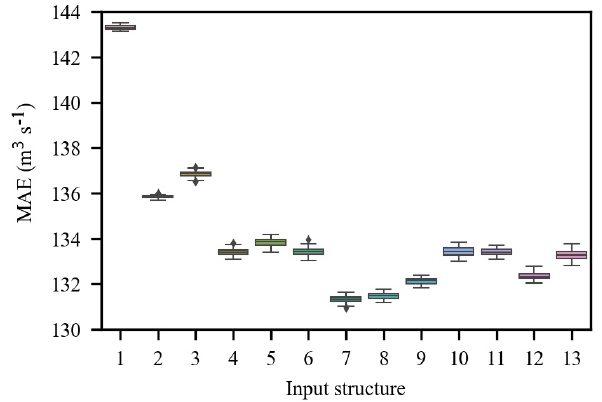
Figure A1. Trial results of 13 input structures from the observed data.